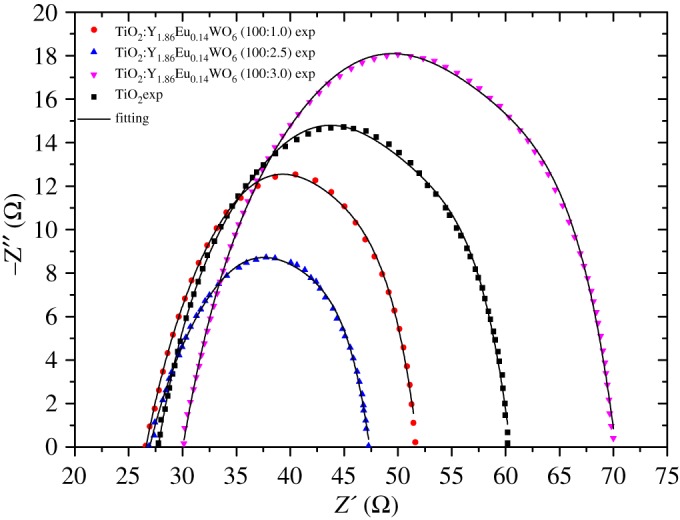
Nyquist plots of the DSSCs based on TiO2/Y1.86Eu0.14WO6 (100:0; 100:1; 100:2.5 and 100:3) photoelectrodes measured at Voc under one-sun illumination.